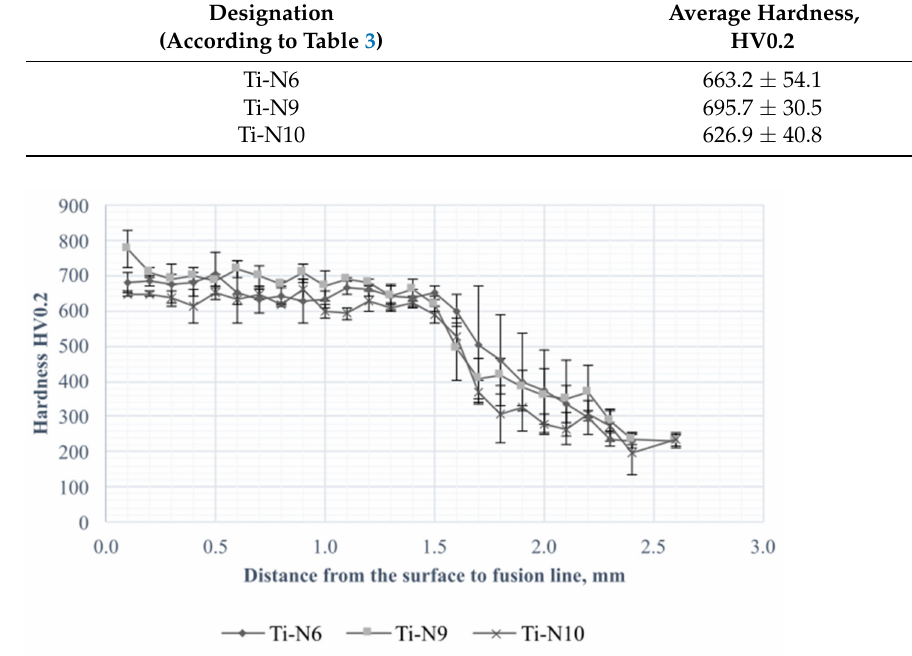
Figure 10. The Vickers hardness depth profiles of homogeneous laser-alloyed surface